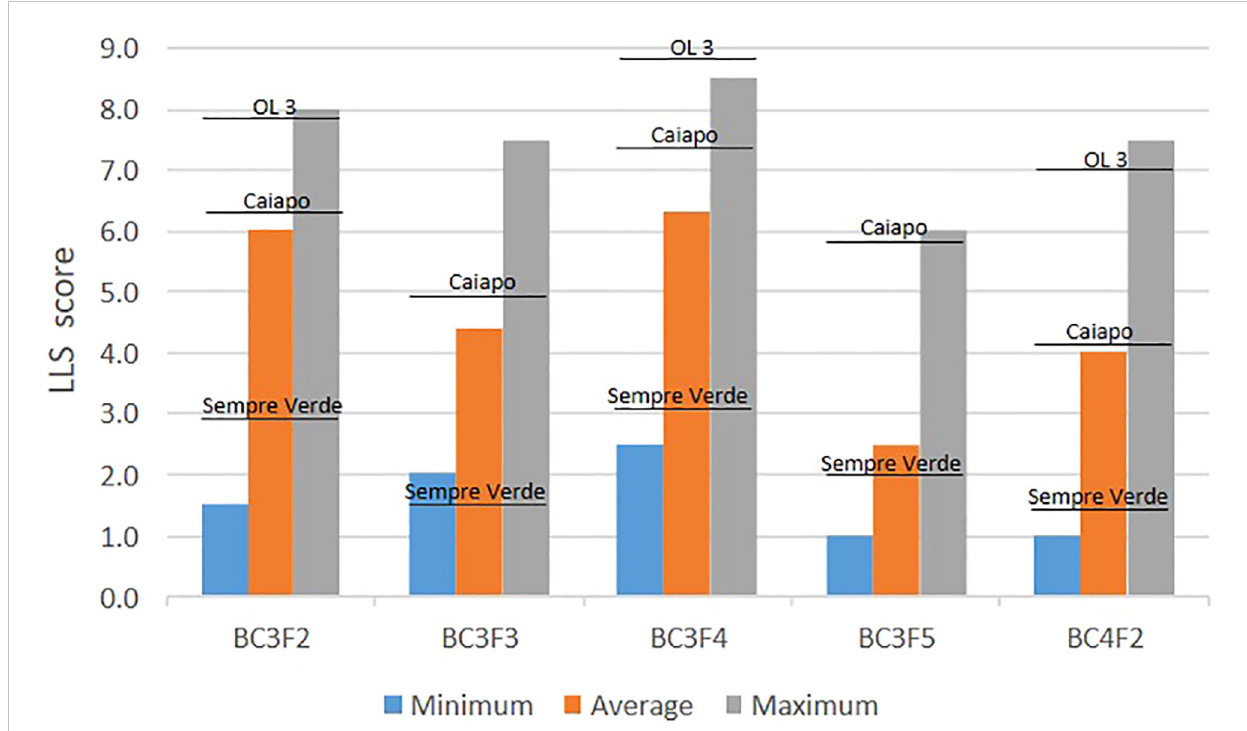
FIGURE 2 Minimum (blue), average (orange), and maximum (gray) LLS scores of 1,235 plants with introgressions from Arachis stenosperma and A. magna of generations BC